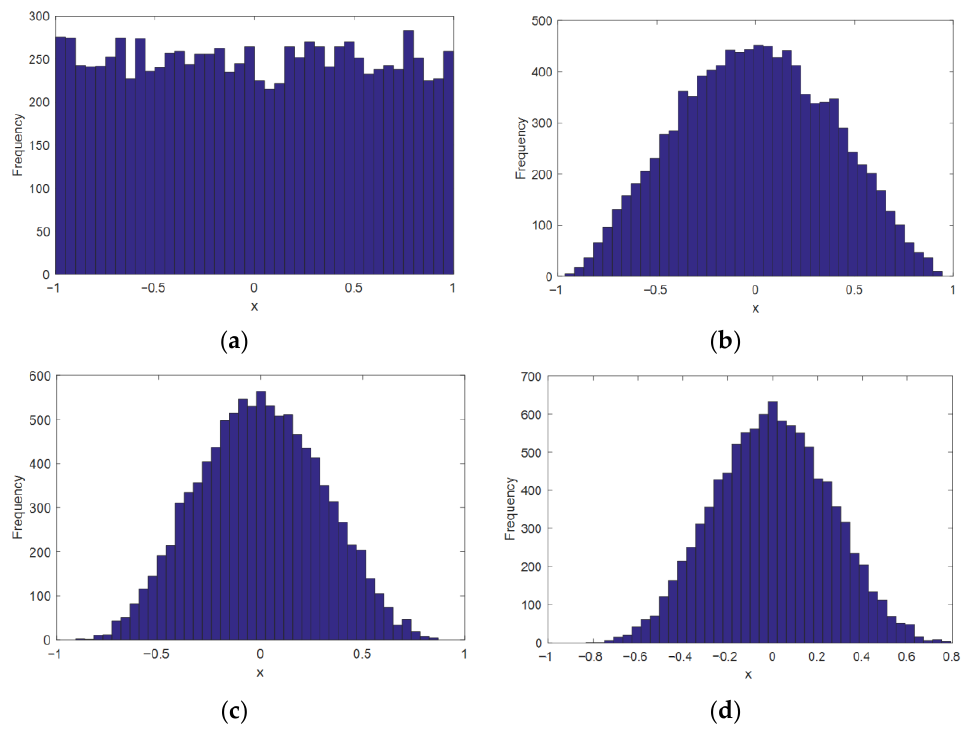
Figure 1. Frequency distribution histograms of random variables: ( a ) x 1 , ( b ) x 2 ( c ) x 3 ( d ) x 4 , x 5 .